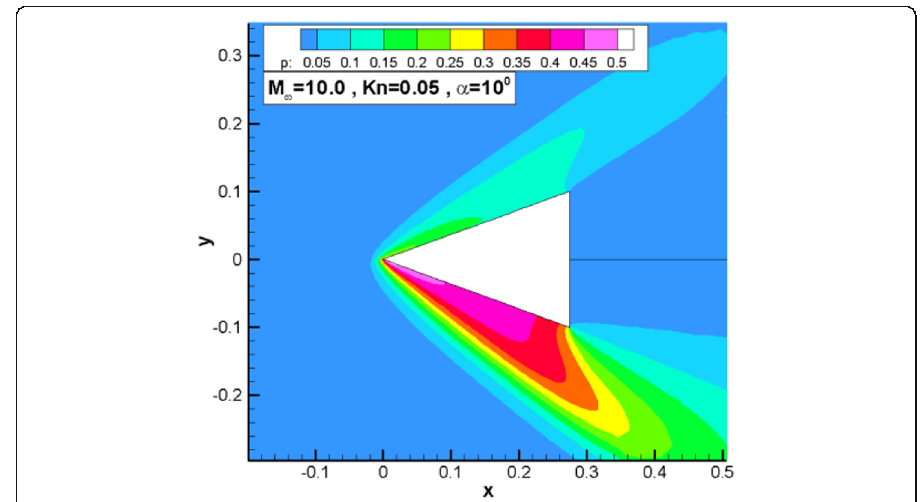
Fig. 4 Pressure contour of the